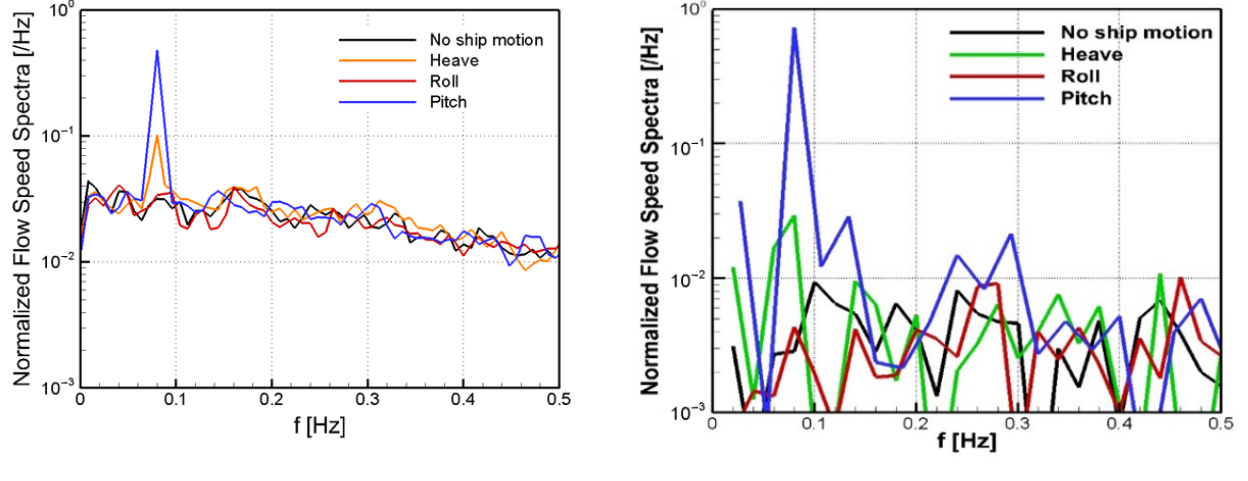
Figure 5. Effect of ship motion on airwakes—spectra of a probe in the airwake middle at the height of the rotor plane in helicopter high hover, adopted from Yuan et al. [15].